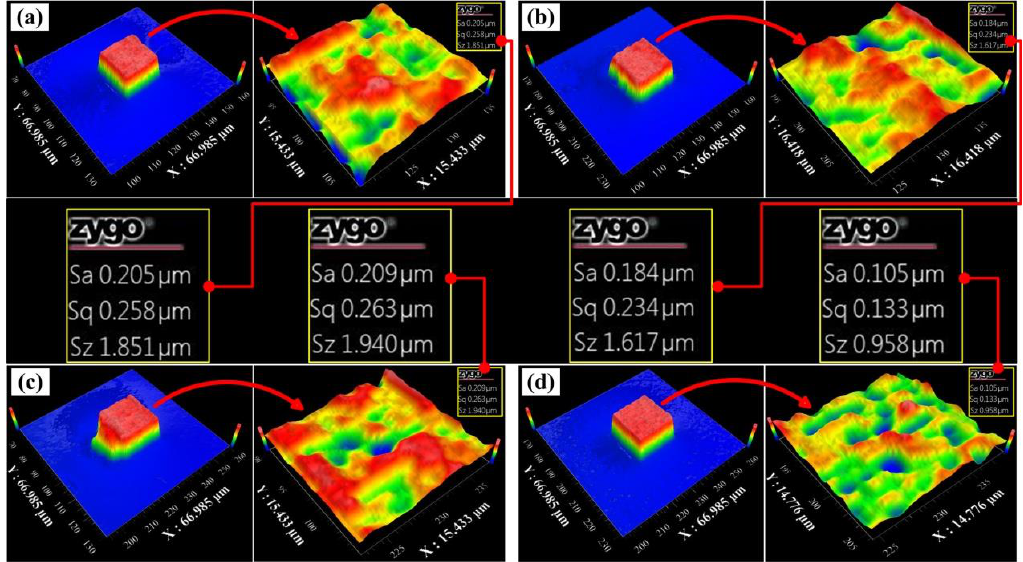
Figure 4. The roughness value was measured by a white light interferometer. Additionally, all the roughness value showed in four random cubes. ( a ) the roughness value of the first cube; ( b ) the roughness value of the second cube; ( c ) the roughness value of the third cube; ( d ) the roughness value of the fourth cube.